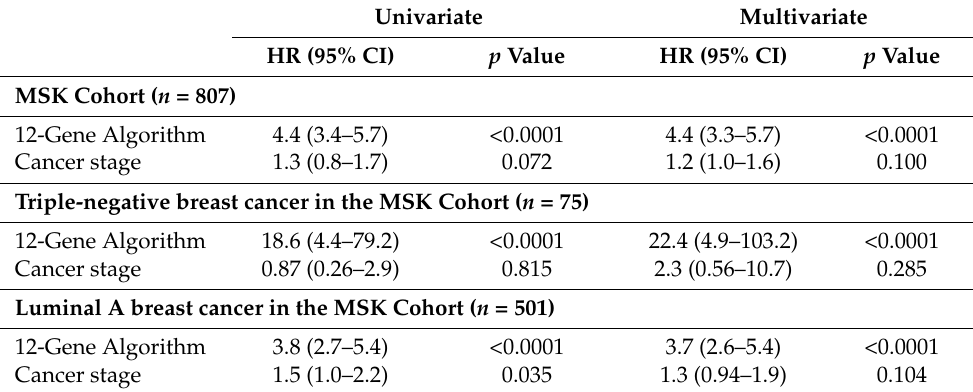
Table 5. Univariate and multivariate Cox regression analyses of the 12-Gene Algorithm and cancer stage for predicting treatment response in the MSK Cohort ( n = 807), triple-negative subgroup ( n = 75), and luminal A subgroup ( n =